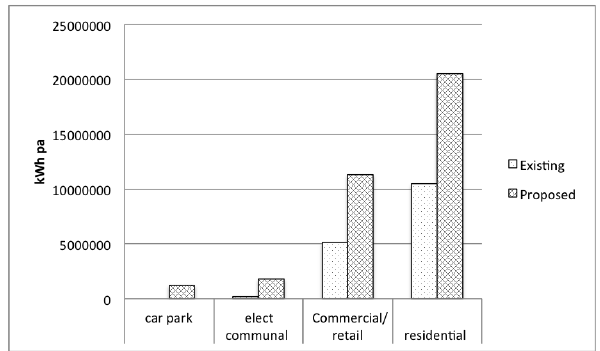
Figure 9. Comparison of all electricity uses.